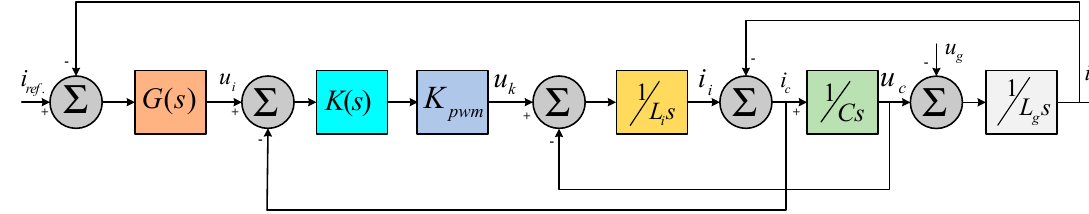
Figure 17. One-leg block diagram of an active damping control strategy for a grid-connected VSI.